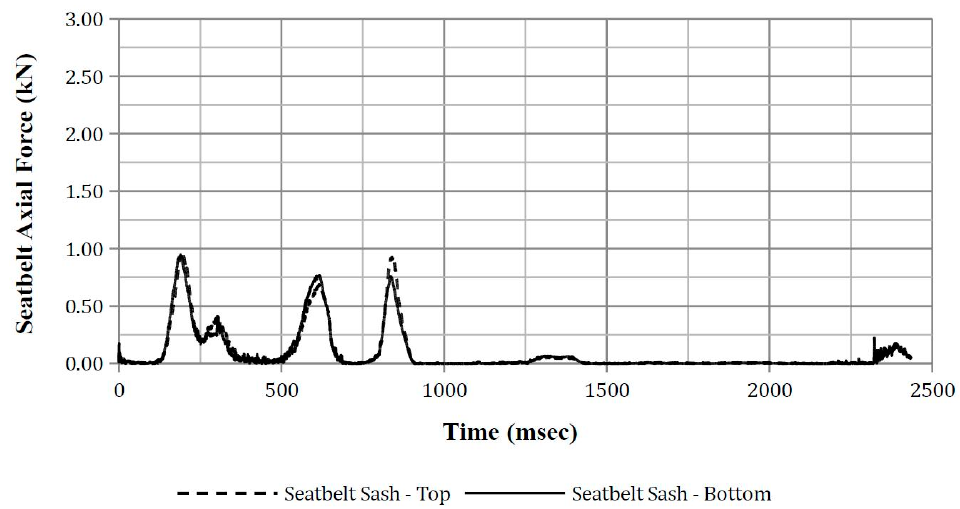
Figure A33. ATD Position 2 sash belt axial force.